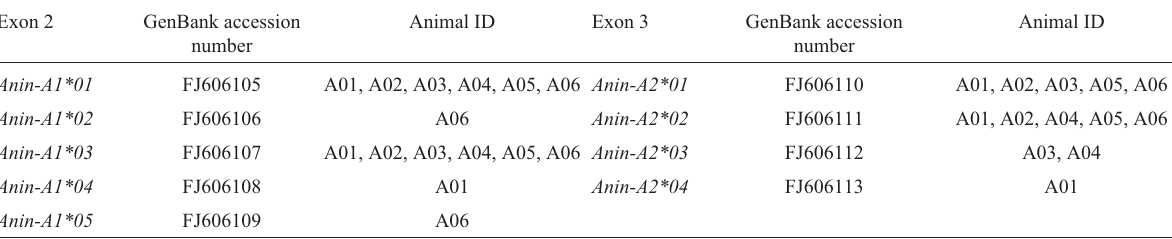
Table 1 - The sequences of exon 2 and exon 3 in the six bar-headed geese